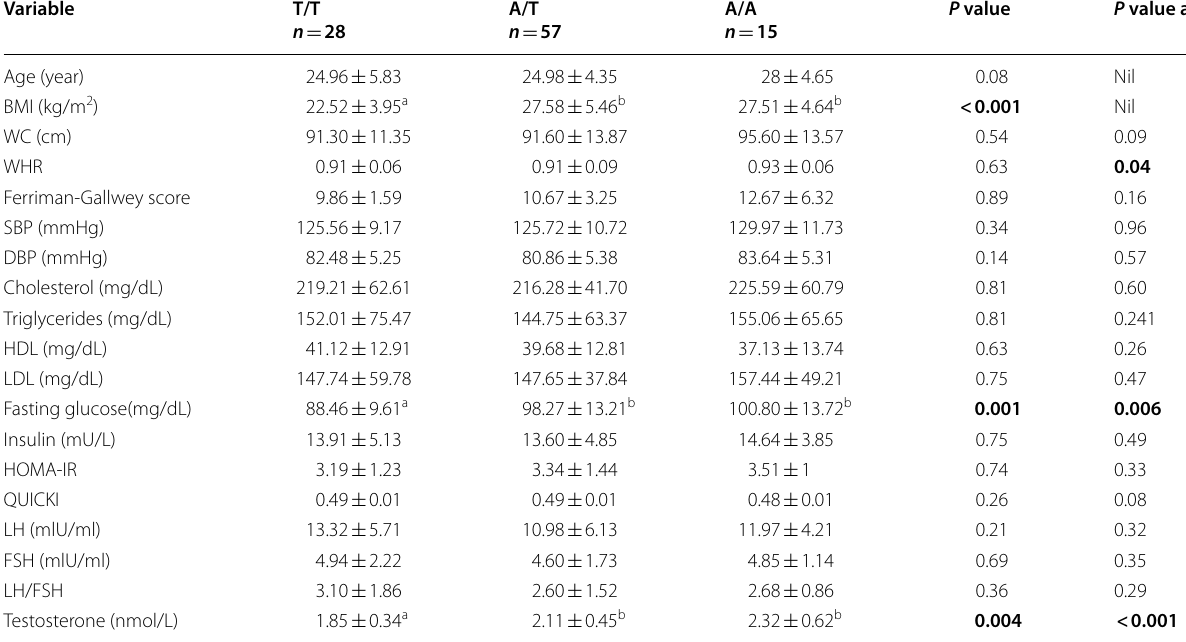
Table 3 Metabolic and endocrine characteristics of the PCOS group according to different genotypes for SNP rs9939609